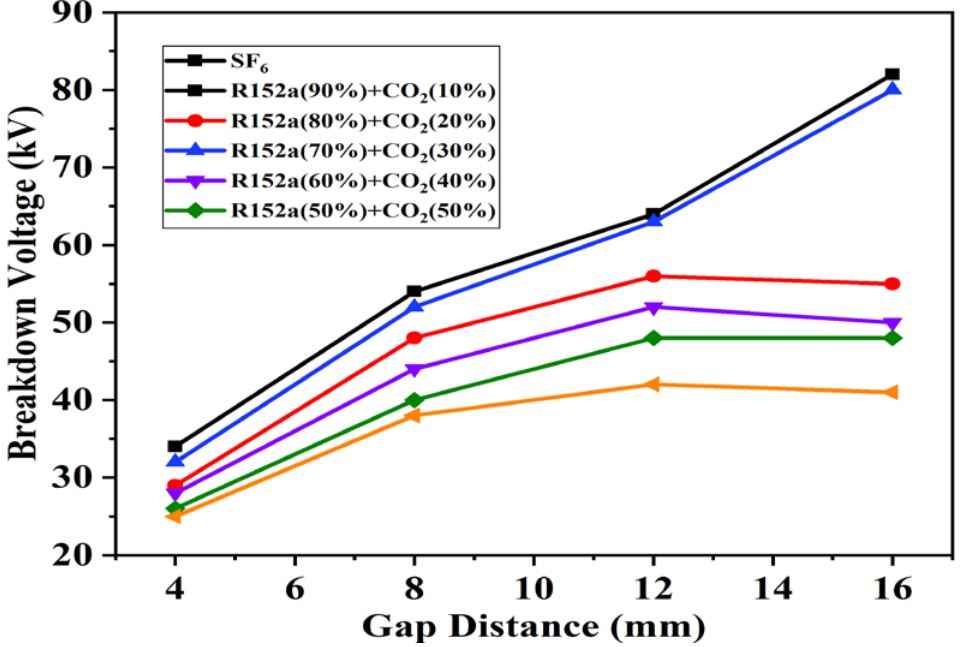
Figure 5. Breakdown voltages of R152a/CO 2 gas varying the gap distance (4–16 mm) at different mixture ratio.